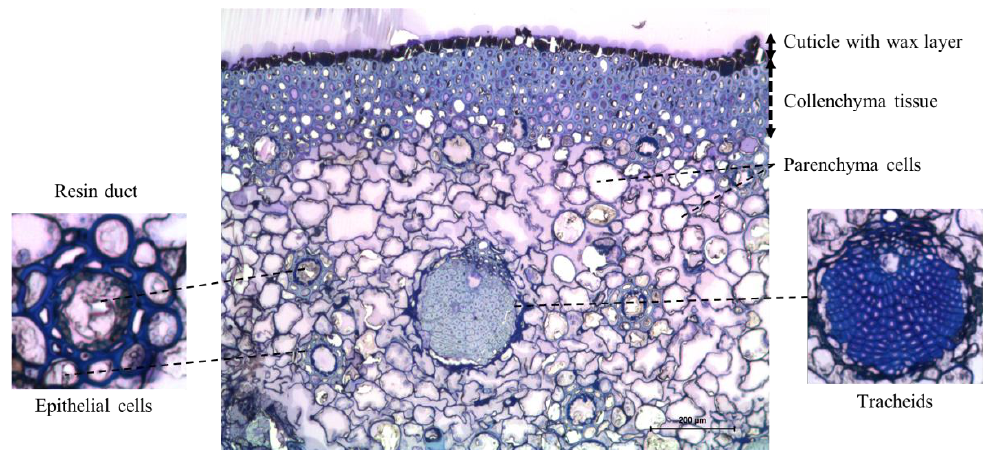
Figure 3. Cone scale of cross-section view in optical microscope. Table 2. Changes in thickness of the cone scale based on dryness and absorption status.